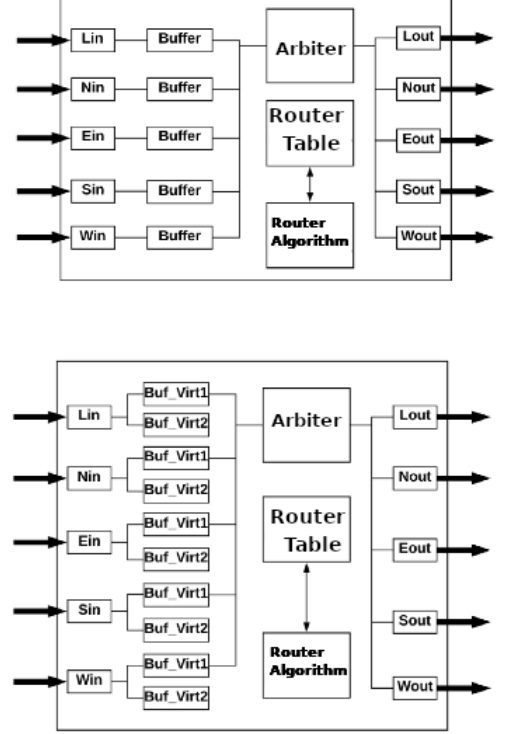
Figure 4. Router models